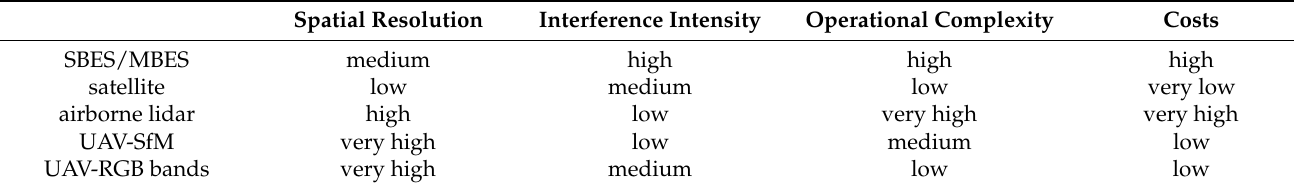
Table 1. Comparison of conventional bathymetric methods (single/multi-beam echosounder systems, SBES/MBES), satellite-derived bathymetry, airborne lidar bathymetry, UAV-based Structure-from-Motion (SfM) photogrammetry and UAV-RGB band-derived bathymetry. Both satellite and UAV-derived spectral bathymetry need measured sample data to train the models, so they have a certain level of interference in the aquatic environment. Spatial Resolution Interference Intensity Operational Complexity Costs SBES/MBES medium high high